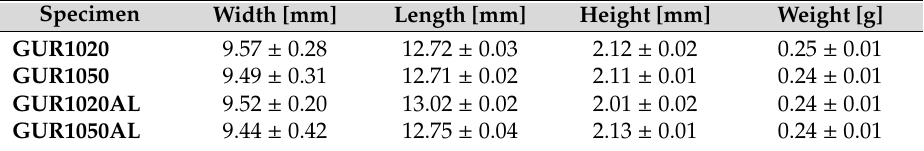
Table 2. Dimensions and Weights of Specimens for Release Testing [N = 10].